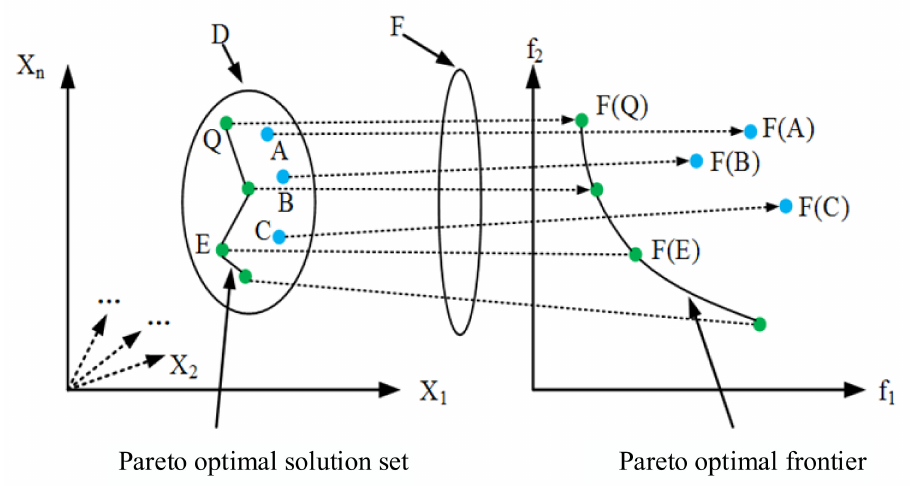
Figure 1. Pareto optimal solution set and Pareto optimal preface example